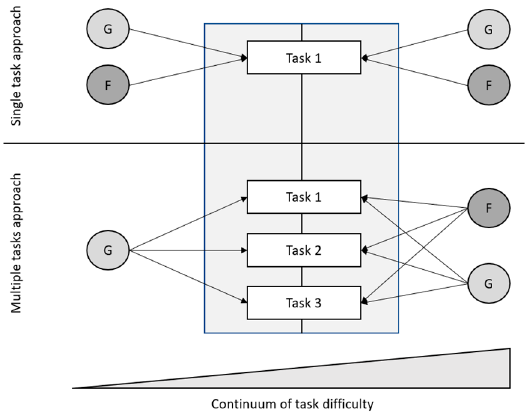
Figure 3. Face specificity in single vs. multiple FC tasks of increasing difficulty. Circular shapes represent underlying abilities (constructs) while angular shapes represent observed performance scores. G—general factor; F—face-specific factor. Task 1–3—these represent possible tasks as proposed in FC research, such as tasks constructed by Herzmann et al. (2008) and applied by Wilhelm et al. (2010). These tasks are not all on the same difficulty level; rather, the tasks position on the easy–hard continuum influences the ratio of task-specific vs. task-independent face processing ability it taps into, represented as face-specific factors in the figure.